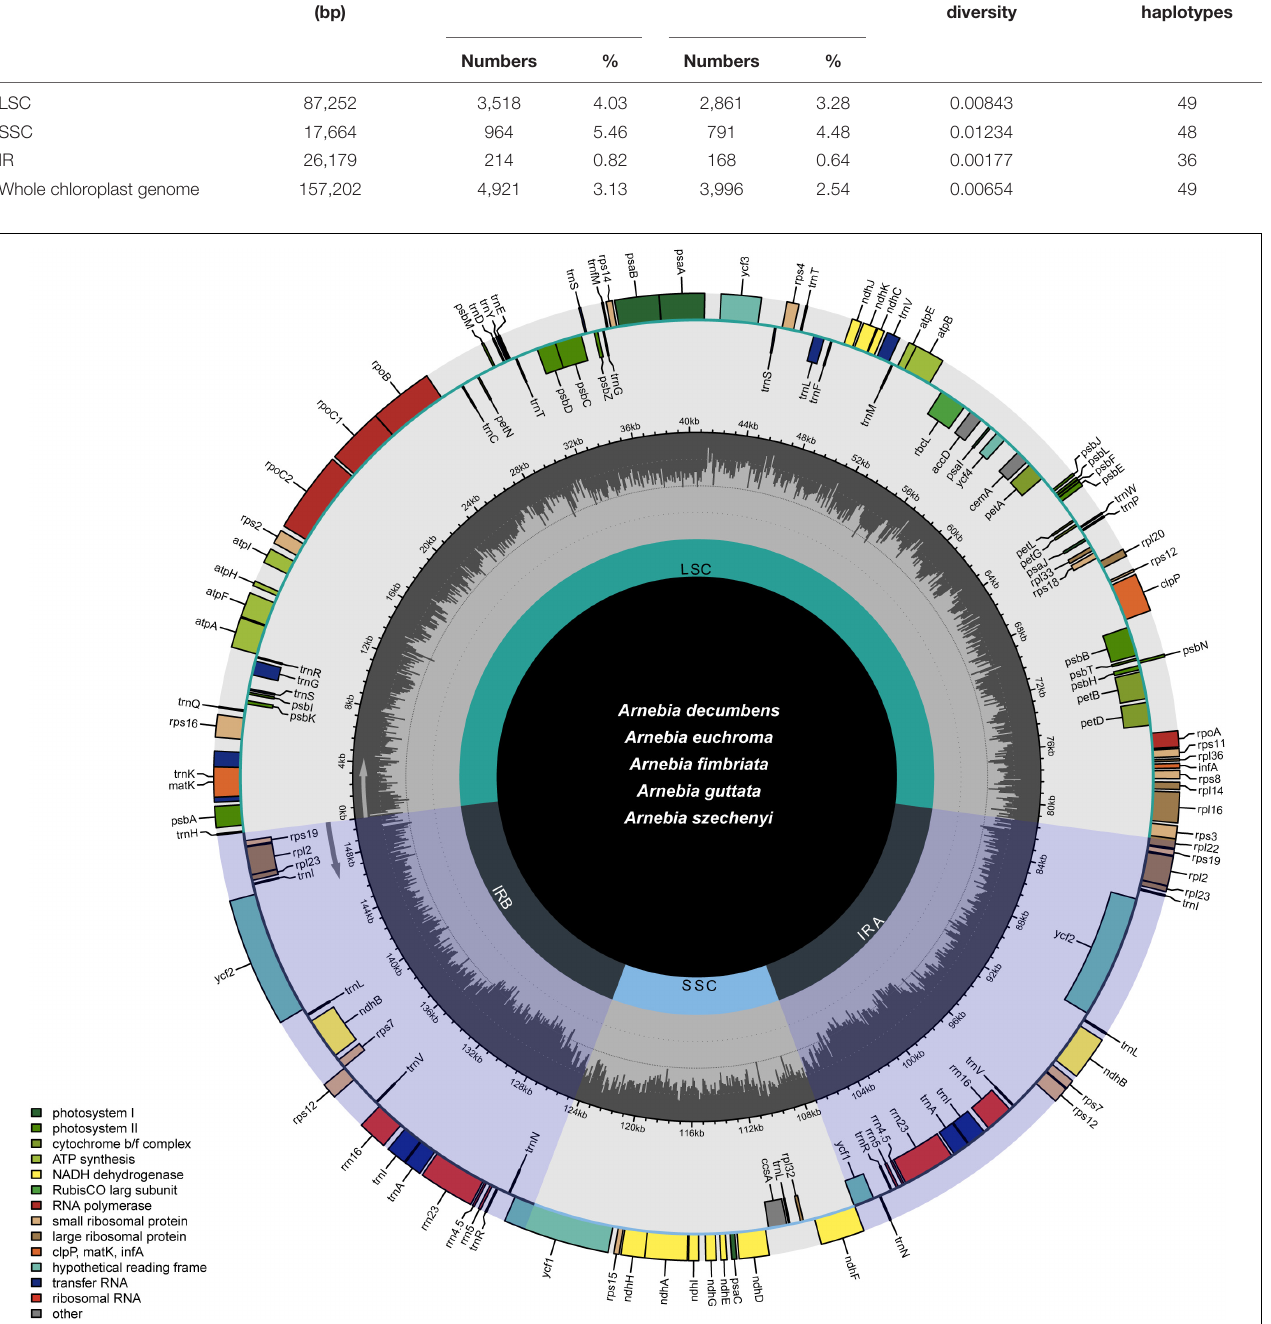
TABLE 2 | Analyses of the variable sites in chloroplast genomes of Arnebia . Regions Aligned length